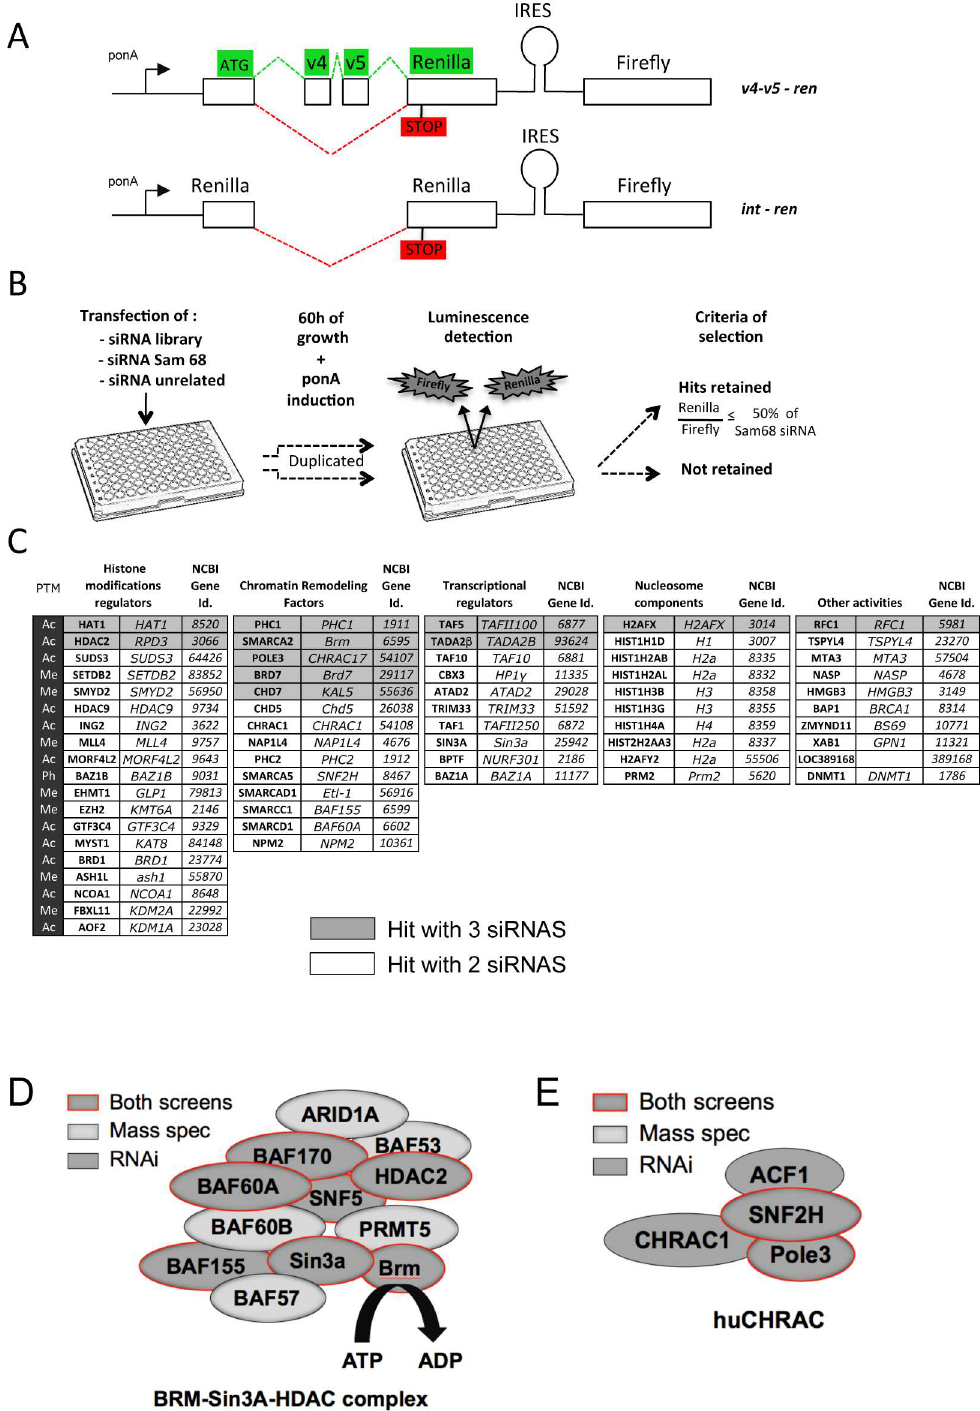
Fig 2. A high-throughputsiRNA screenfor chromatin factorsthataffectsplicing. (A) Diagram of the bi- cistronic v4-v5–ren and int-ren minigenereportersused to follow splicing by luminescence. Rectanglesrepresent exons, stem-loop structures represent InternalRibosomeEntrySites (IRES).Splicing regulationleadingto a functional Renilla is indicated in Green, while those producingto a non-functional Renillaare markedin Red (B) Outlineof the procedureused to screen a libraryof siRNAs targeting375 chromatinfactors. Each gene was targetedwith an average of 3 individualsiRNAs, testedin duplicates. (C) List of chromatin factors